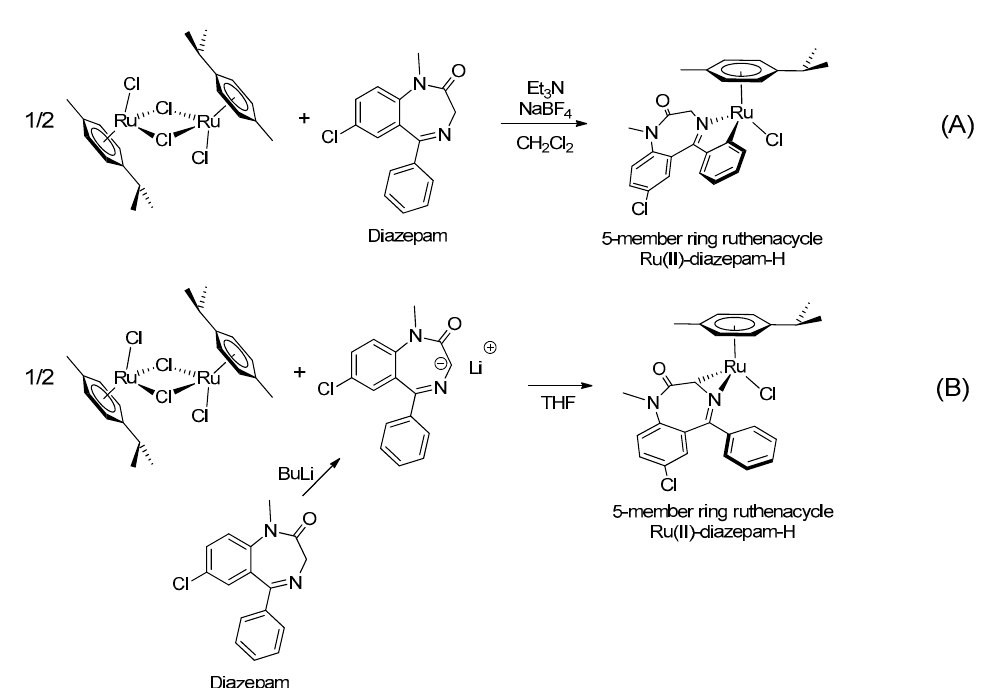
Figure 8. Organometallic compounds of ruthenium derived from BZDs ( A and B ).